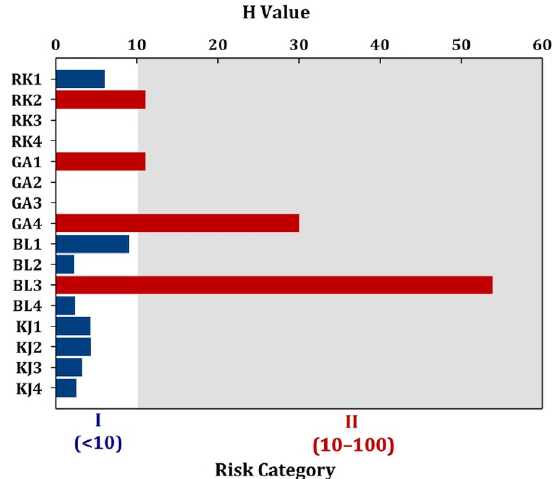
Figure 6. Environmental risk evaluation of MPs in the sediments of East Surabaya, Indonesia.